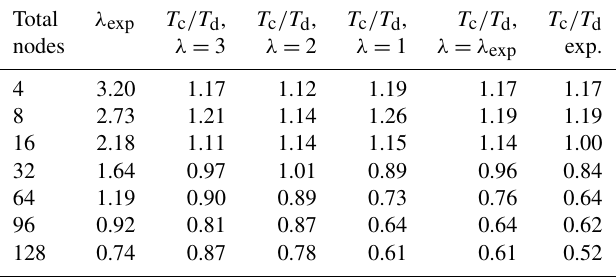
Table 2. As Table 1, for the 40km experiment. The ratio of the ICON-O to the HAMOCC cores is constant, 1 / 3, and is omitted.